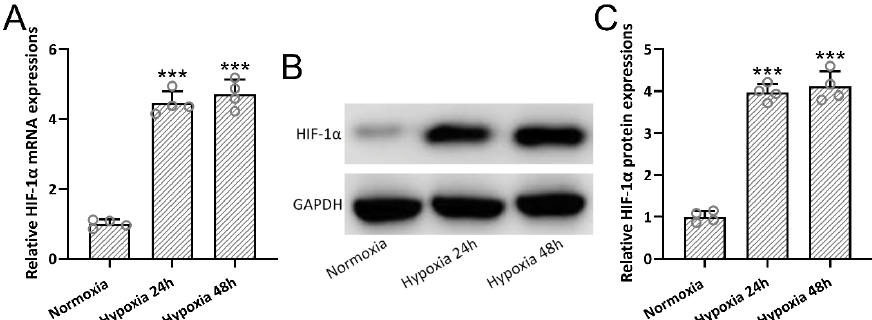
Figure 2. The expressions of HIF- 1α in BMSCs after hypoxia treatment. The relative mRNA expres- sions ( A ) and protein expression ( B ) of HIF- 1α at different times after hypoxia treatment. Quantita- tive Western blot results are demonstrated ( C ). The data are shown with mean ± SD. The experi- ments were repeated 4 times with pooled cell lysates from each group. *** p < 0.001 compared to normoxia. One-way ANOVA followed by Tukey’s multiple comparisons test. BMSCs, bone marrow mesenchymal stem cells; HIF- 1α , hypoxia-inducible factor- 1α ; SD, standard deviation.